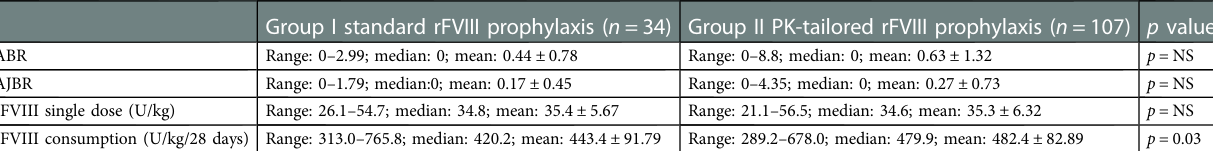
TABLE 5 Comparison of bleeding rates and factor consumption in patients on standard prophylaxis group vs. PK-tailored prophylaxis